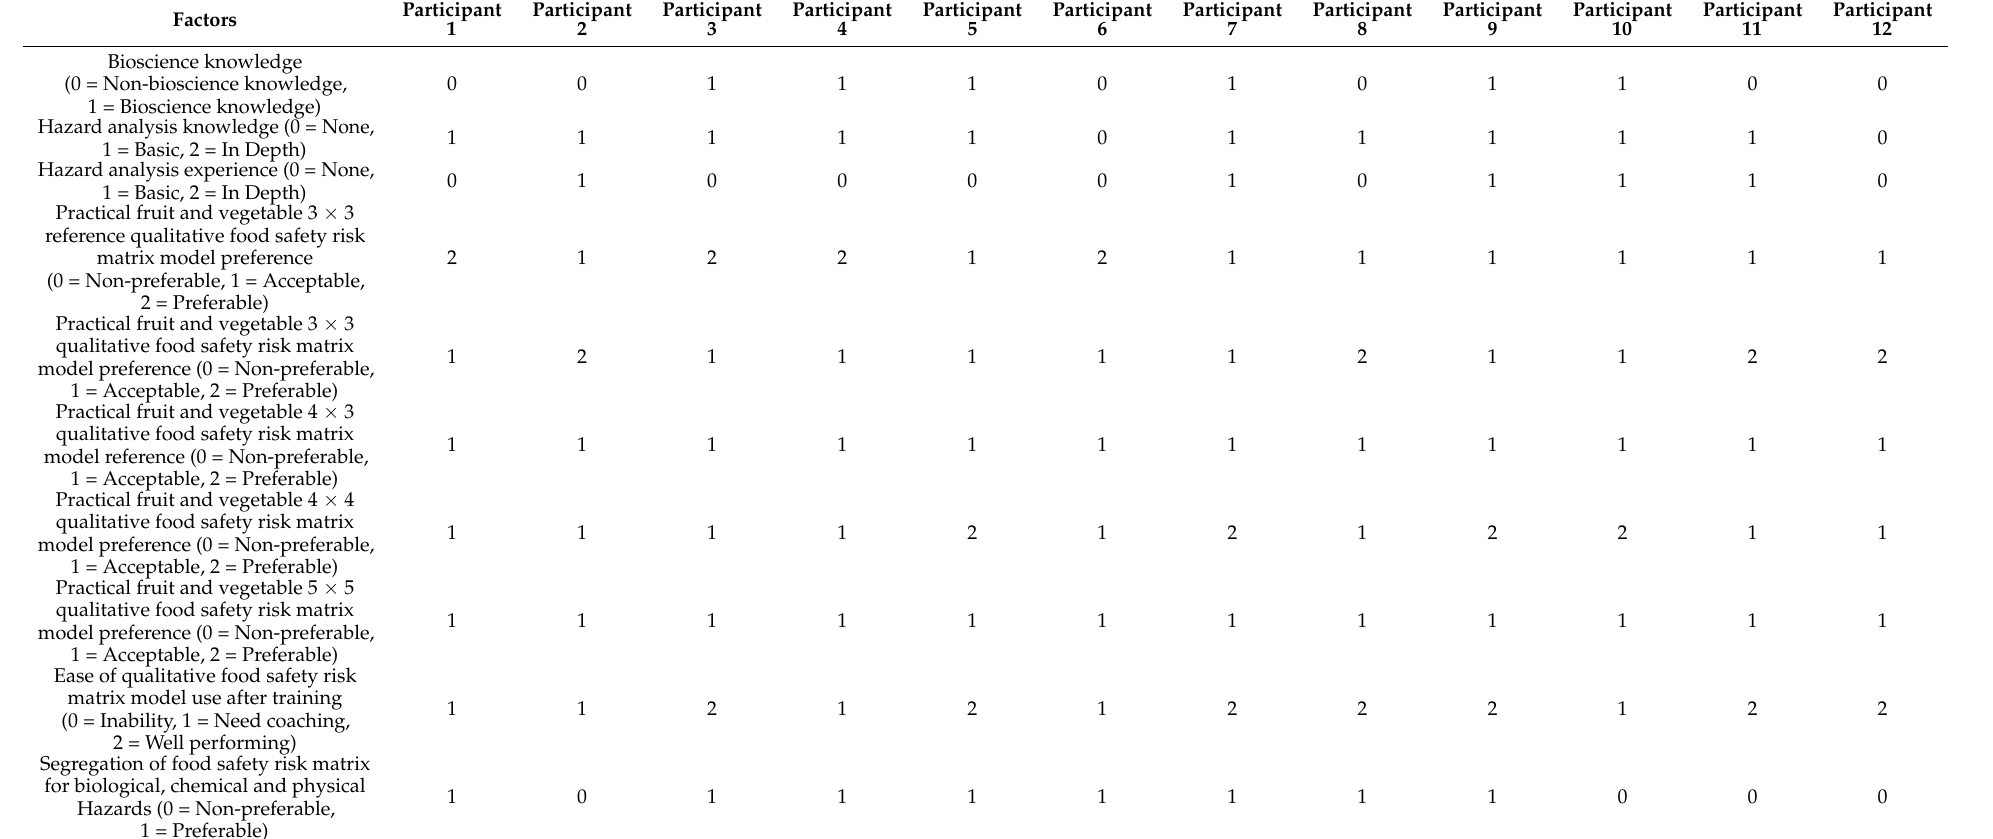
Table 7. All practical fruit and vegetable qualitative food safety risk matrix models’ preference